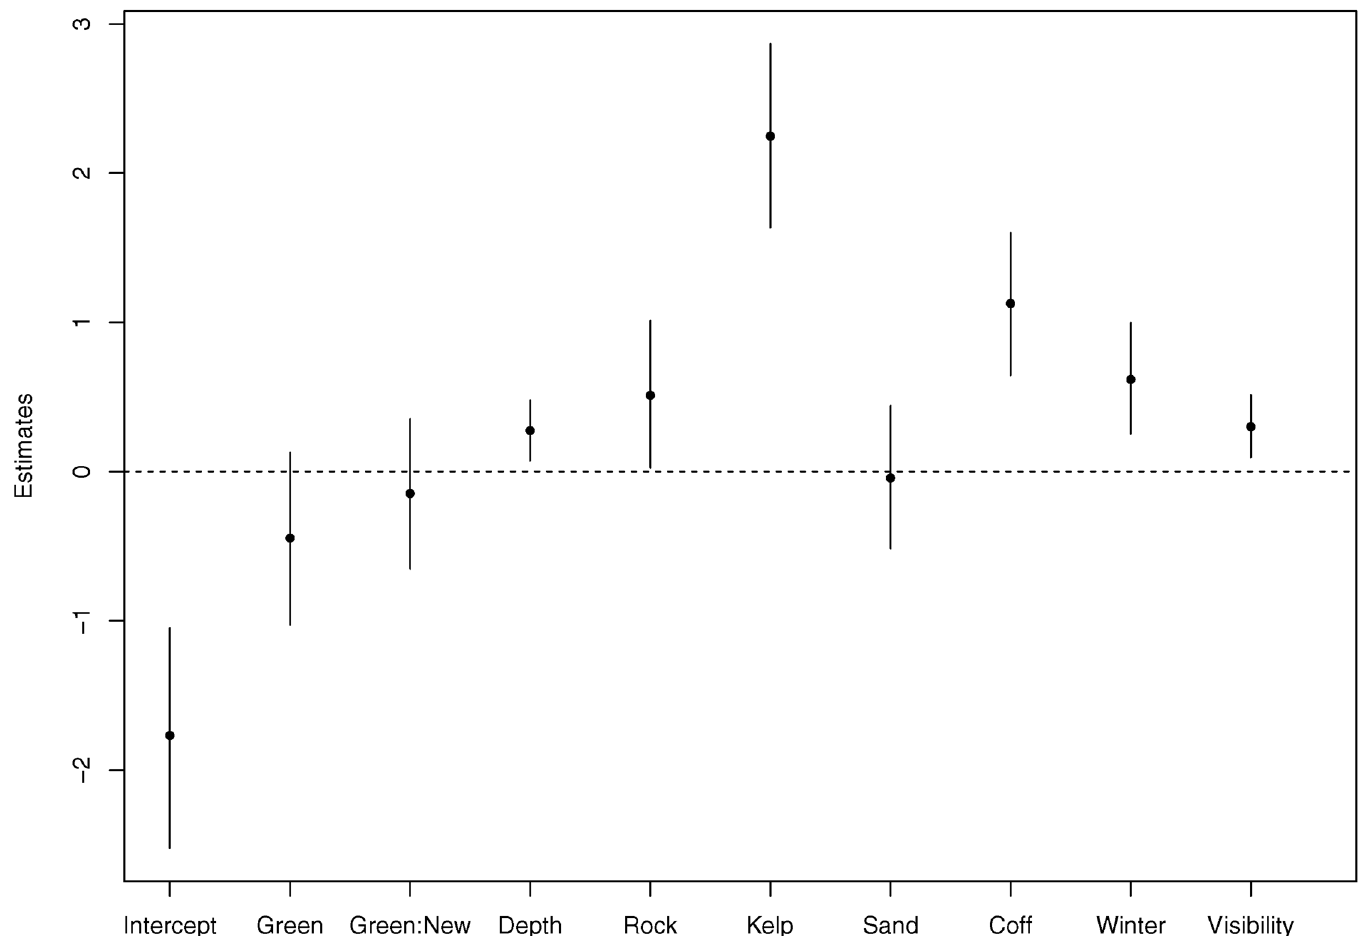
Fig 2. Estimates for the coefficients in the Non-Spatial model. Posterior means and 95% credible